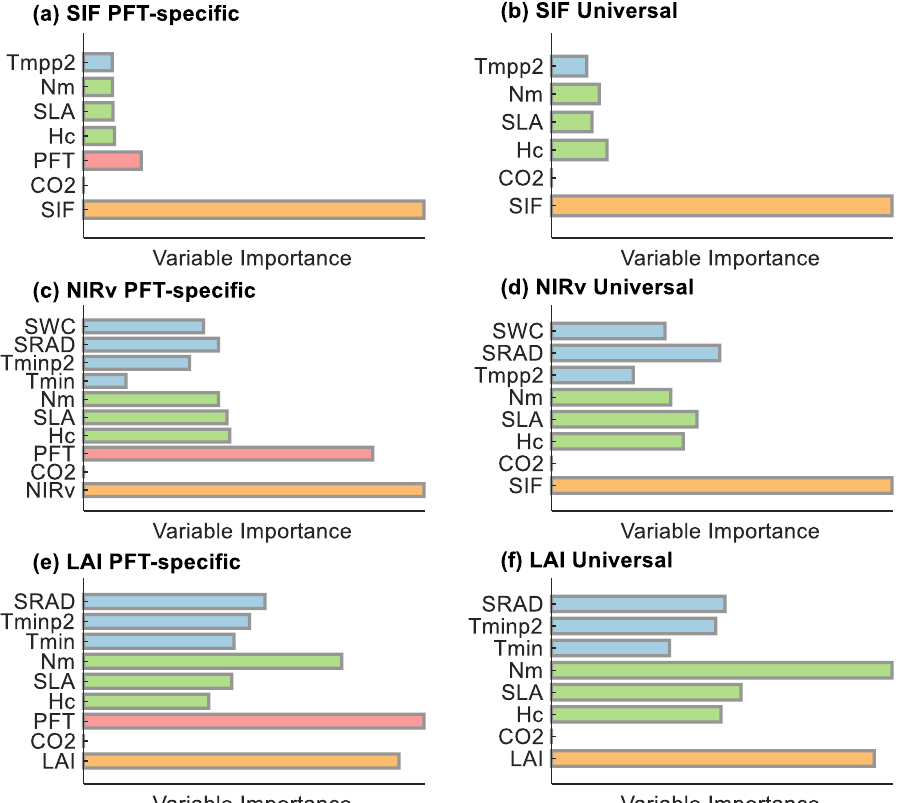
Figure 6. Importance of variables for optimal performance in random forest models. ( a , c , e ) represent PFT-specific models. ( b , d , f ) represent universal models. Rows one through three represent the models constructed based on SIF, NIR v, and LAI, respectively. Variable importance scores were normalized using the minimum–maximum method. The explanatory variables are marked with “px” at the end of the abbreviation, indicating the climate factors for the previous x months (e.g., Tminp2 represents the minimum air temperature two months ago).